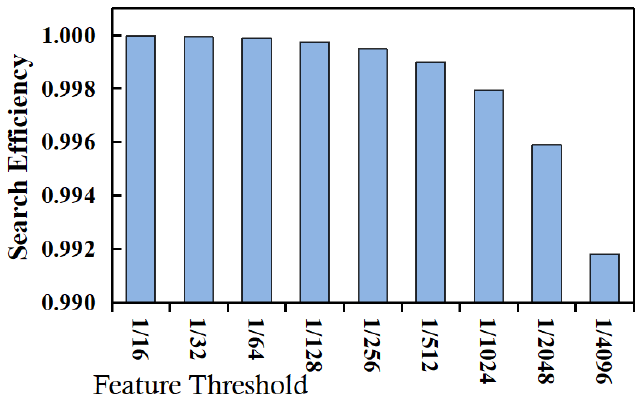
Figure 4. Evaluation results for numeric data range query efficiency.